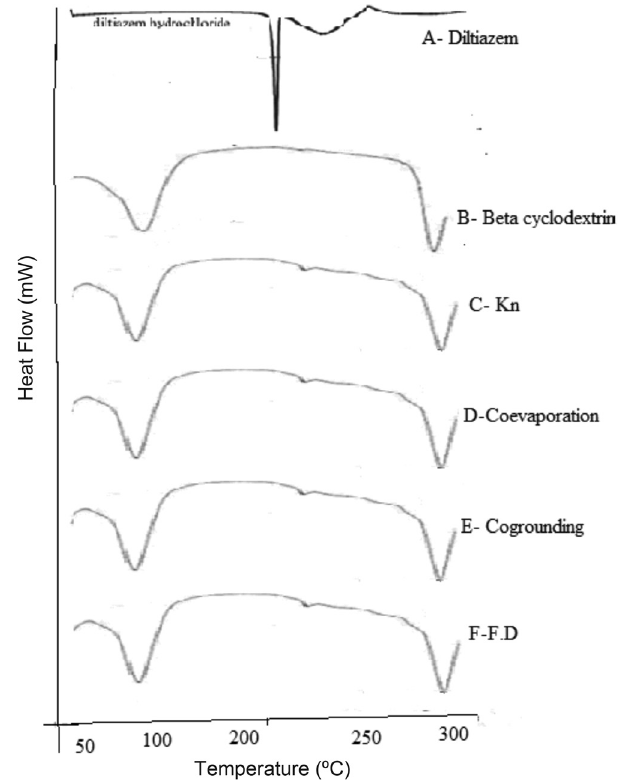
FIGURE 5 - Differential scanning calorimetry